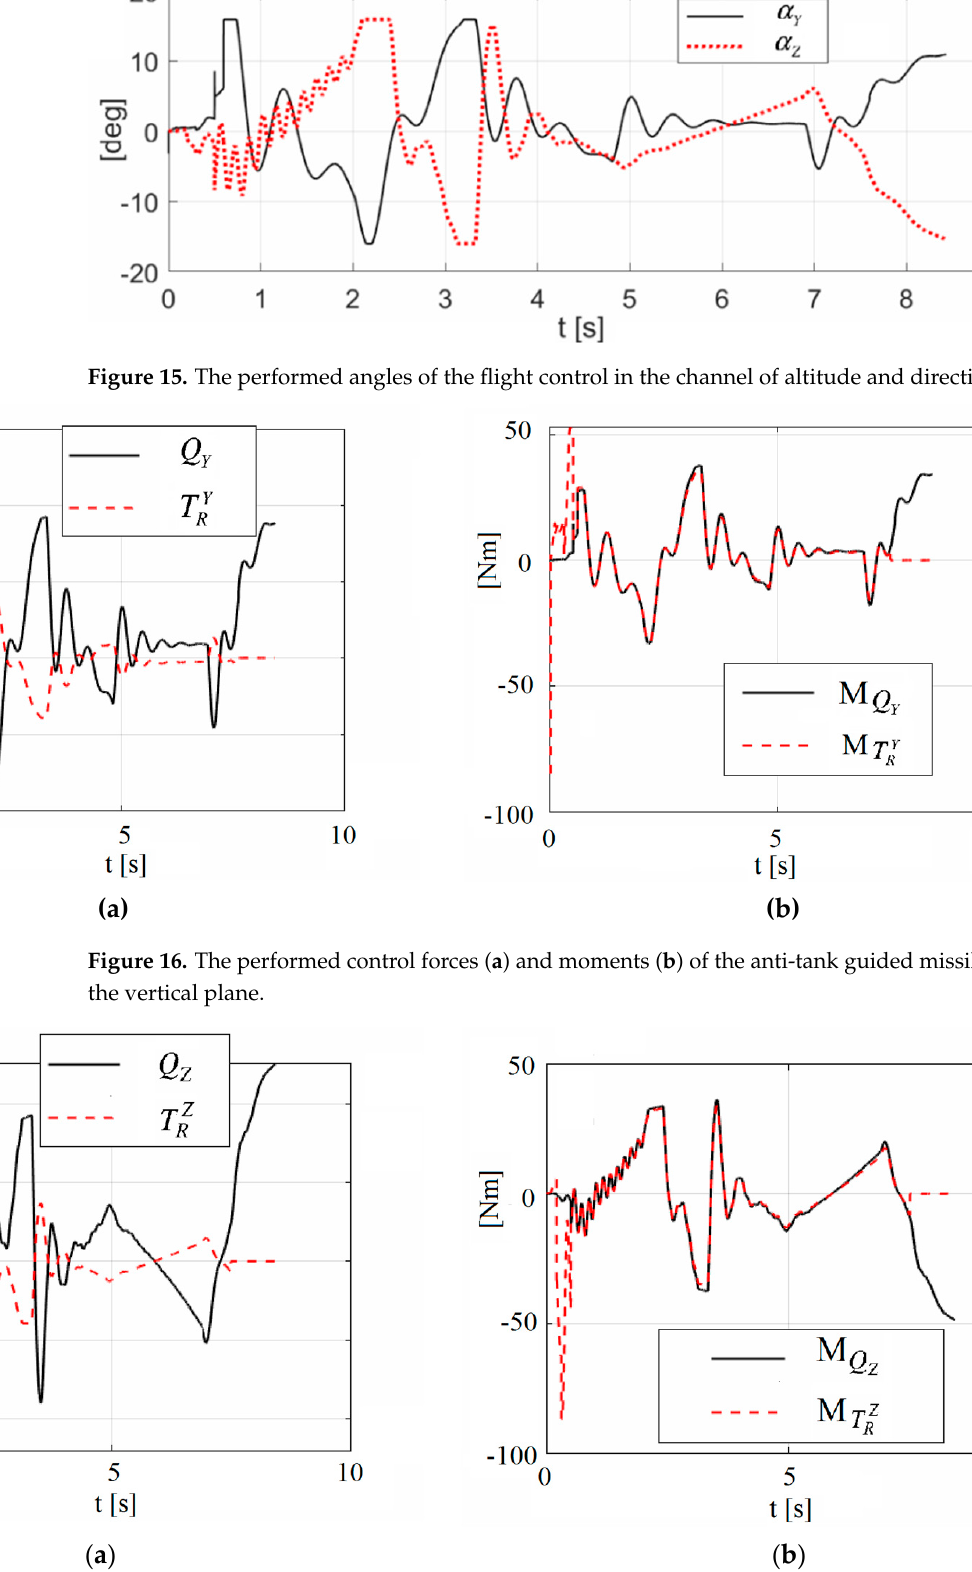
Figure 17. The performed control forces ( a ) and moments ( b ) of the anti-tank guided missile flight in the horizontal plane.